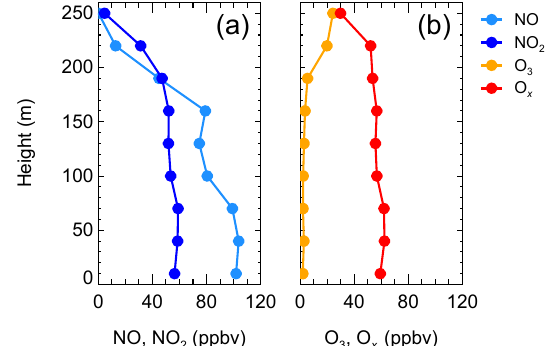
Figure 5. Vertical profiles of (a) NO and NO 2 and of (b) O 3 and O x at 09:06–09:34 on the morning of 20 December 2016.